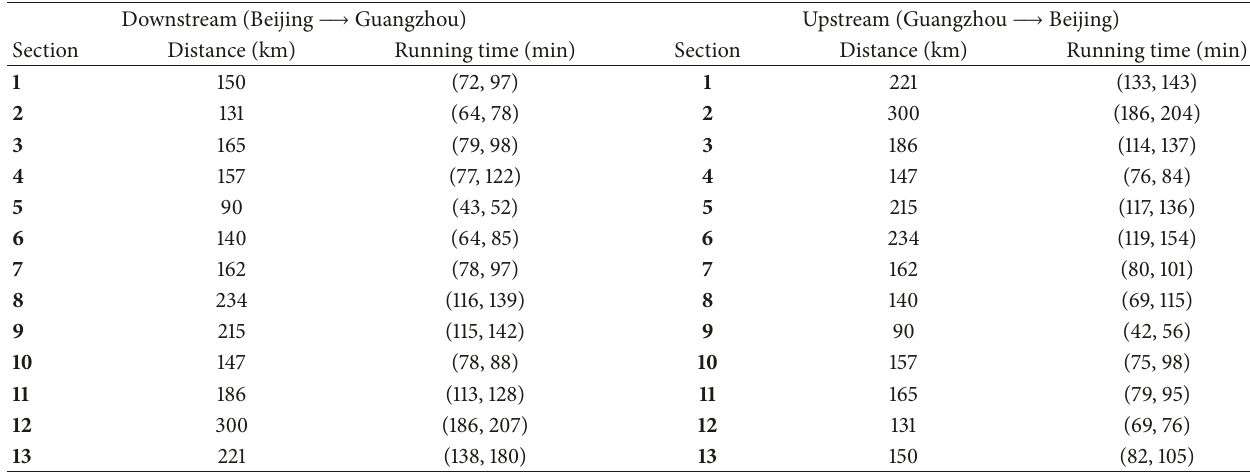
Table 4: Information of distance and running time on the normal-speed